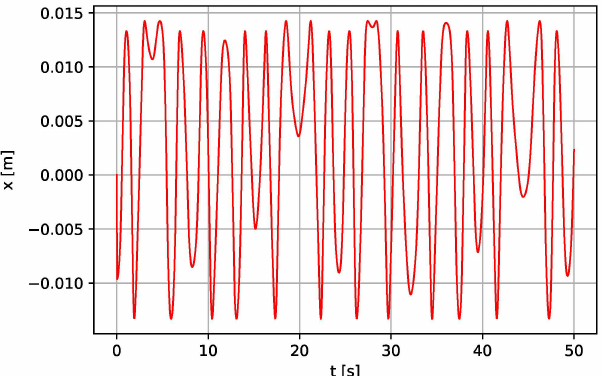
Figure 19. Linear displacement x ( t ) of the lever (Case II—a variable length concept of the pendulum pump) for c p = 0.1 N